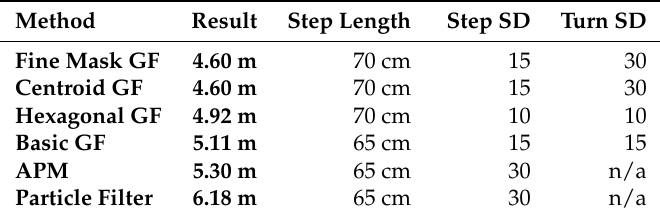
Table 2. The best overall result for every considered method on the IPIN 2018 validation dataset.